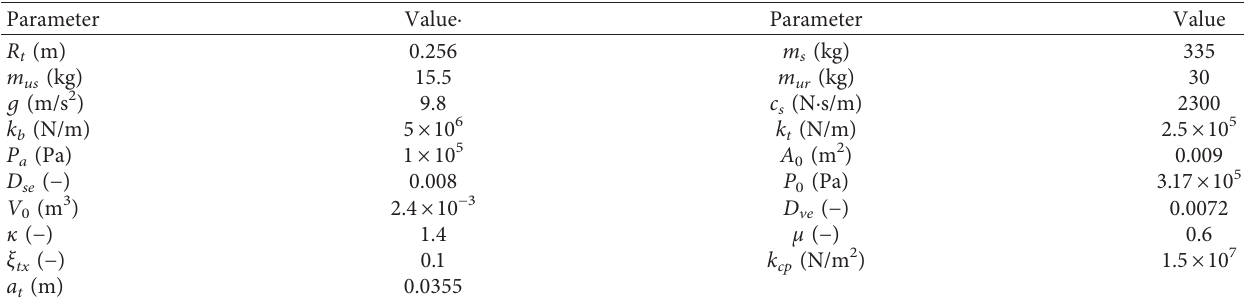
Table 3: Parameters of the three-DOF quarter car model considering real-time UMP.